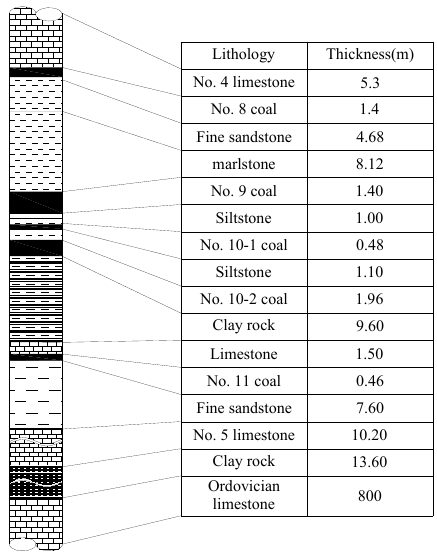
Figure 4. Backfill mass strength with time.